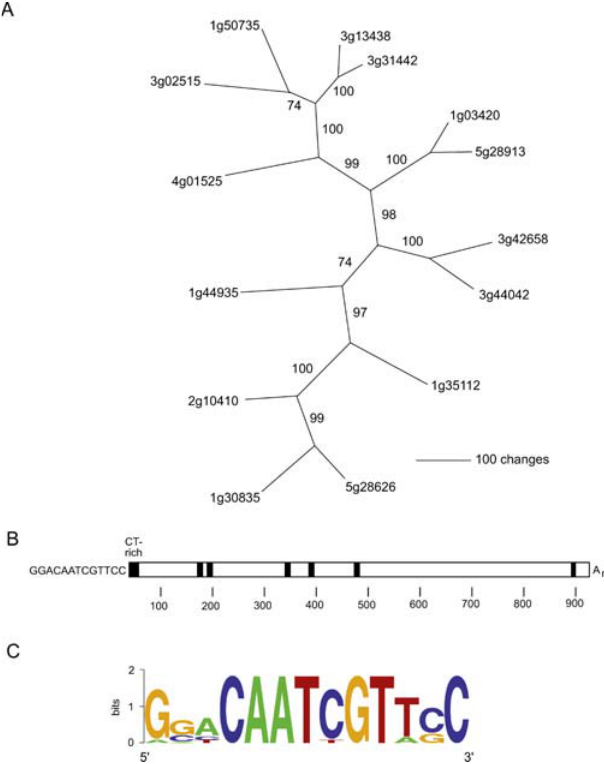
Figure 5. Sadhu Retroposon Family Members in the Arabidopsis Col Genome (A) An unrooted phylogram of 14 full-length Sadhu elements built using a maximum parsimony algorithm. Bootstrap values are shown (100 bootstrap replicates). (B) Diagram of consensus sequence structure of a full-length Sadhu element based on ClustalX gapped alignment. Black boxes indicate short blocks (10–20 nucleotides) of high sequence conservation, including a CT-rich block toward the 5 9 end. The majority of elements end with a poly(A) tract (Table 3). (C) A conserved 13-bp sequence at the predicted 5 9 boundary of the element is illustrated as a logo diagram based on alignment of the 14 homologs shown in (A) [72]. DOI: